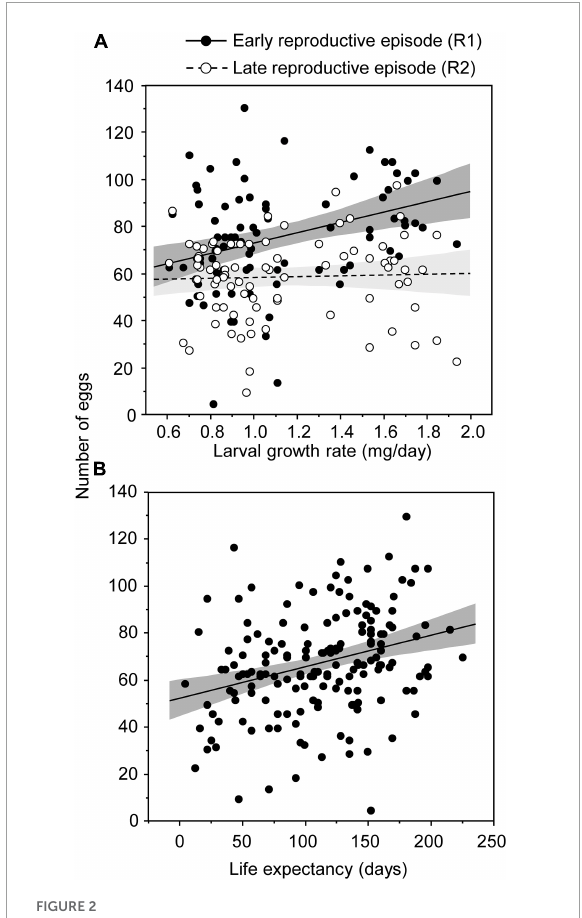
FIGURE2 Number of eggs laid by Tenebrio molitor as a function of the female’s growth rate according to the reproductive episode (early reproductive episode, R1: females 10–20 days old post-eclosion; late reproductive episode, R2: females 40–50 days old post-eclosion) (A) and as a function of life expectancy at reproductive episode (B) . Each dot represents the measure of a single female during one reproductive episode. Lines are linear regressions with 95% confidence intervals.